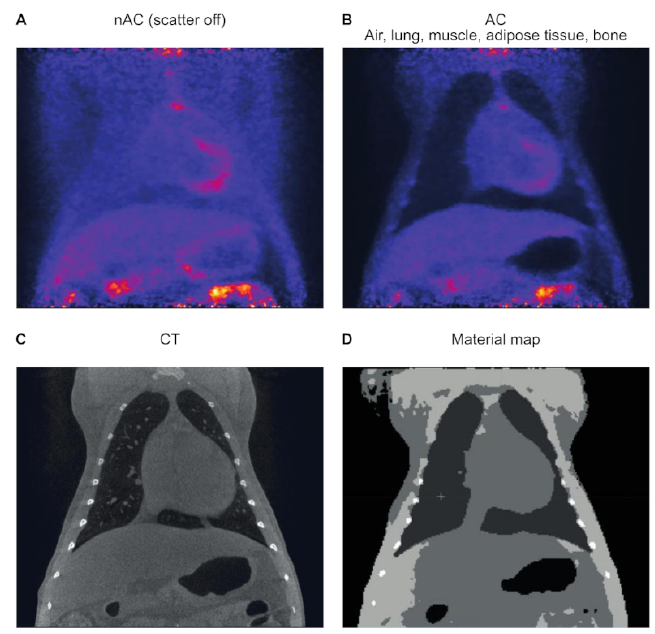
Figure 7. Representation of the same scan and cross section without ( A ) and with ( B ) attenuation correction, including the corresponding CT ( C ) and representative material map in which the different ranges used to discriminate different tissue densities ( D ). The attenuation correction is based on six different ranges: air, lung, muscle, adipose tissue, and bone. The lungs are only discriminated with attenuation. Similar window-level settings are applied to all cross